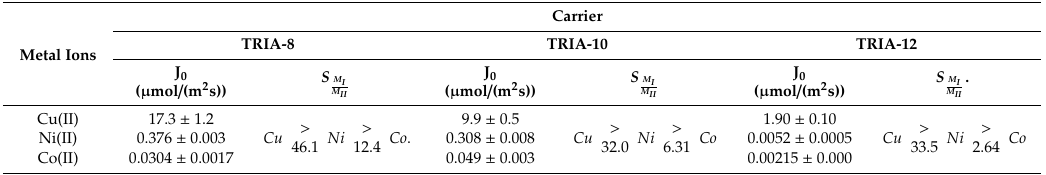
Table 8. Initial flux and selectivity coe ffi cients for the competitive transport of Cu (II), Ni (II), and Co (II) ions by PIMs with TRIA-n (n = 8,10,12) as a